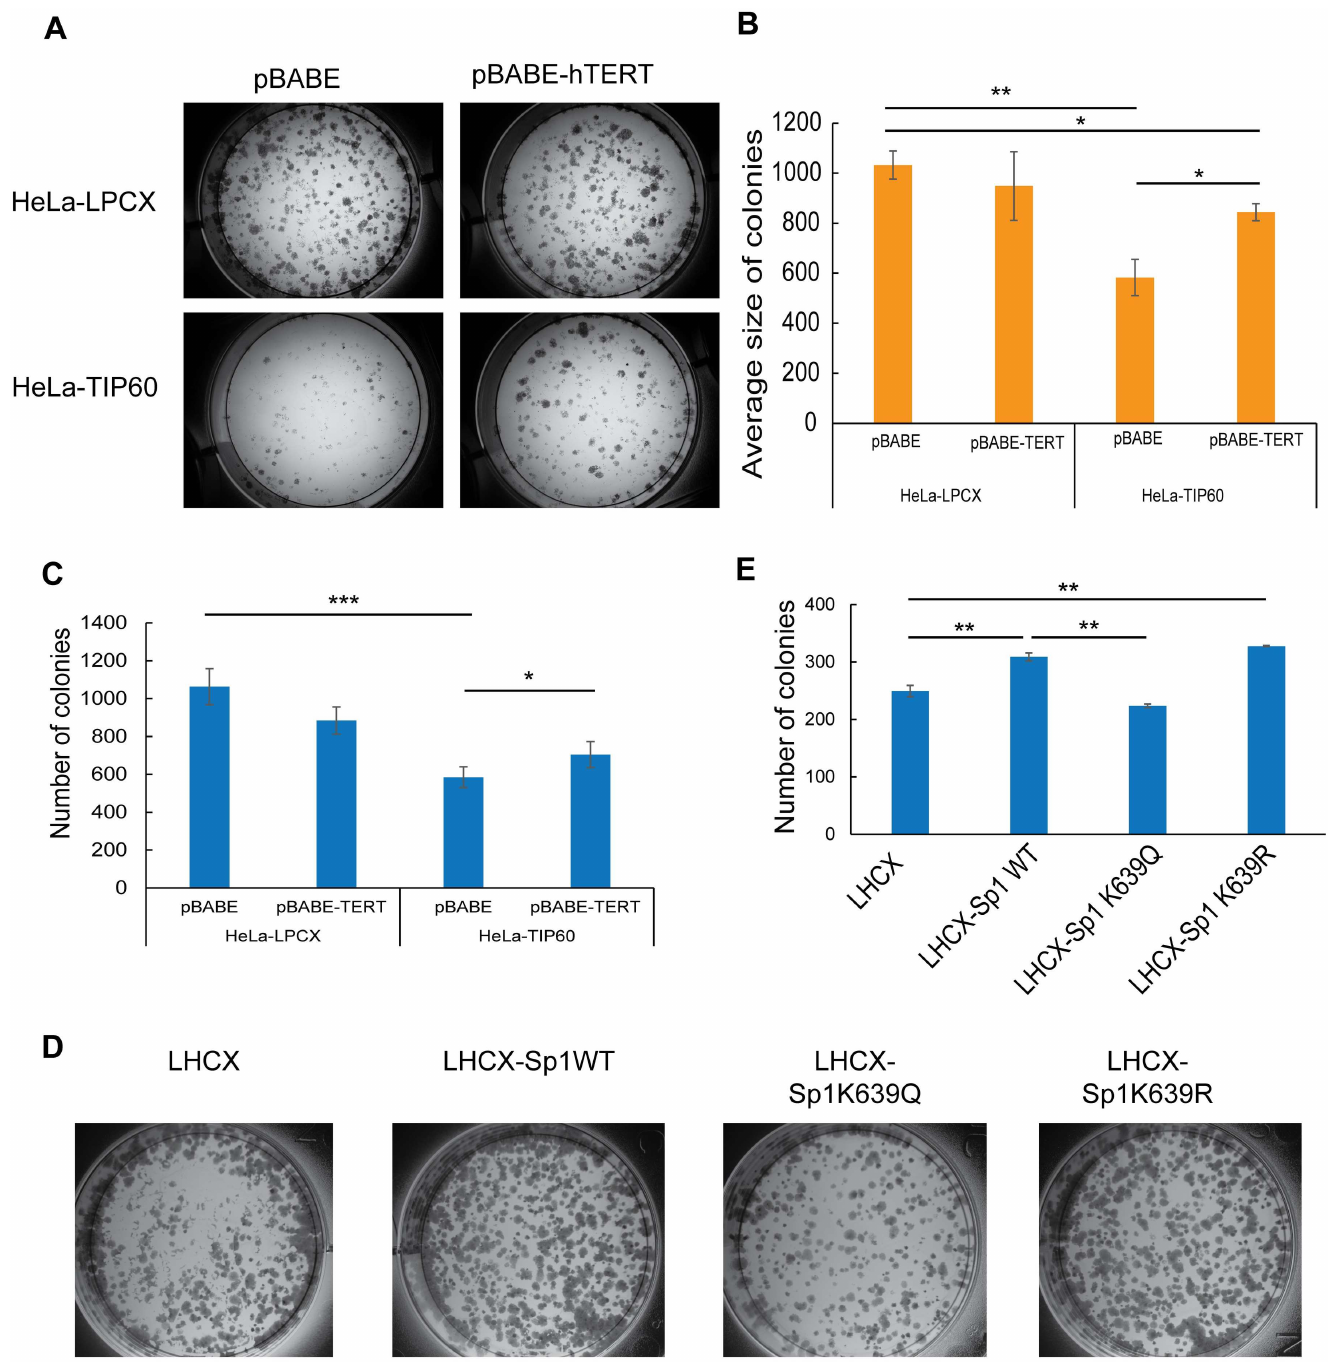
Fig 5. TIP60-mediated growth defects can be rescued by TERT overexpression and are dependent on Sp1 acetylation. ( A ) Representative image from ColonyFormation Assay (CFA) where HeLa-LPCXand HeLa-TIP60 cells transiently transfected with pBABE (vector) or pBABE-TERT were seeded at a low density (2 × 10 3 cells). The cells were allowedto grow for 11 days before fixing and staining with crystal violet. ( B, C ) Bar graph shows the quantificationperformed using Image J software for averagesize and number of coloniesrespectively.The overexpression of TIP60 reduces average colony size, which is rescuedupon overexpression of TERT in HeLa-TIP60. ( D ) Sp1 plasmidsin LHCX vector backbonewere transfected into HeLa cells. Twenty four hours post transfection, 2500 cells were seededfor colony formation assay and representativeimages are shown. 11 days after, they were fixed and stainedwith crystal violet and ( E ) numberof colonieswas quantifiedusing Image J software. Error bars reflect the standarderror of mean (SEM) and significanceis represented as * , P < 0.05, ** , P < 0.01, *** , P < 0.001.